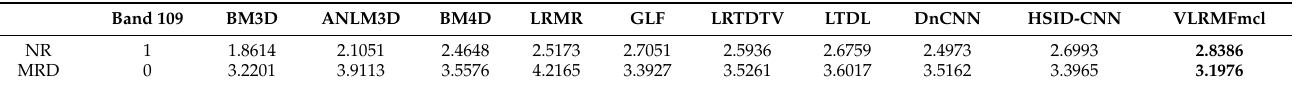
Table 2. Quantitative evaluation of noise reduction (NR) and mean relative deviation (MRD) for band